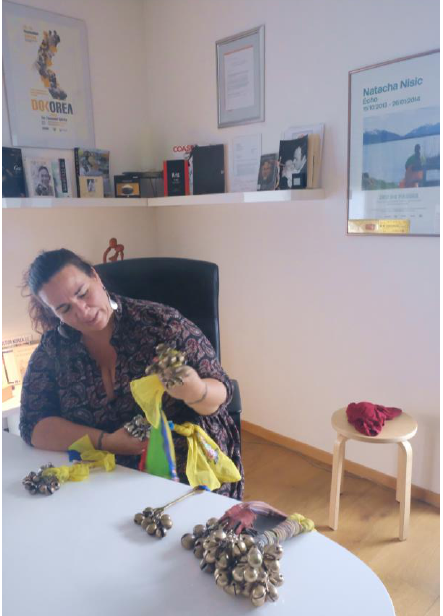
Figure 6. Andrea Kalff in her home shrine in Germany, polishing brass bells in preparation for ritual. Behind her hang posters of documentary films featuring her. May 2022, the photograph was taken by the author with consent from the person depicted.